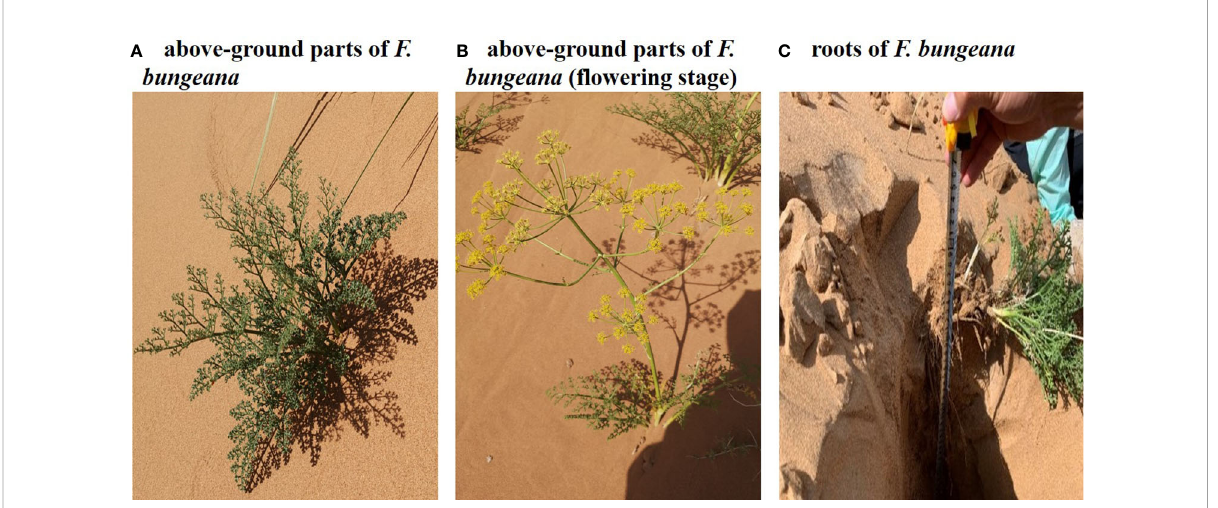
FIGURE 2 Photographs of Ferula bungeana growing on mega-dunes in the Badain Jaran Desert. (A, B) present the above-ground parts of Ferula bungeana and (C) present the root system of Ferula